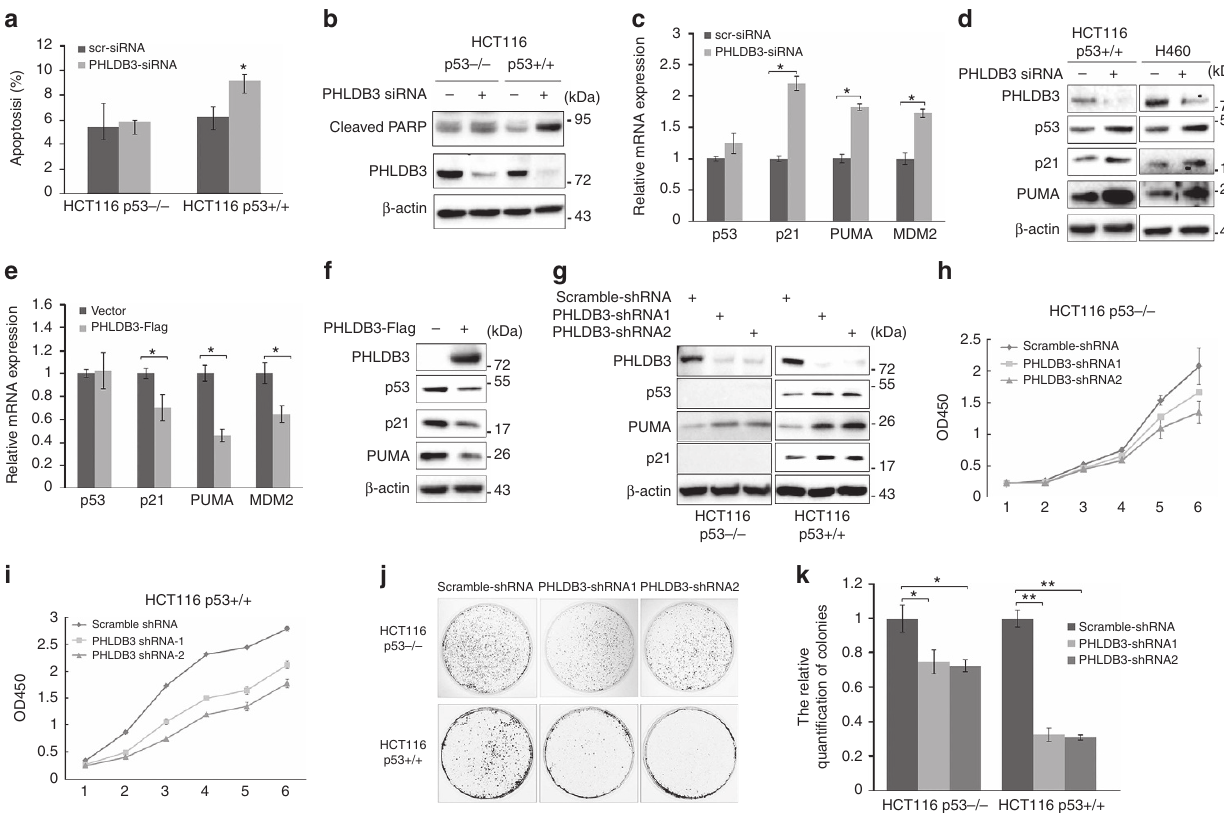
Figure 4 | PHLDB3 knockdown inhibits cell proliferation and promotes apoptosis of colon cancer cells by inducing p53 protein level. ( a , b ) The effect of PHLDB3 knockdown on apoptosis of HCT116 p53 (cid:2) / (cid:2) and HCT116 p53 þ / þ cells. HCT116 p53 (cid:2) / (cid:2) and HCT116 p53 þ / þ cells were transfected with PHLDB3 or scramble siRNA and harvested 72h post-transfection for flow cytometry analysis ( a ) or immunoblotting with indicated antibodies ( b ). Quantification of Sub-G1 population is shown in a . ( c – f ) Knockdown of PHLDB3 induces, but overexpression of PHLDB3 reduces, p53 and its target genes. HCT116 p53 þ / þ ( c , d ) and H460 ( d ) cells were transfected with PHLDB3 or scramble siRNA and harvested 72h post transfection for RT-qPCR ( c ) or immunoblotting with indicated antibodies ( d ). HCT116 p53 þ / þ cells were transfected with PHLDB3-Flag or vector plasmid and harvested 48h post transfection for RT-qPCR ( e ) or immunoblotting with indicated antibodies ( f ). ( g ) Knockdown of PHLDB3 causes p53-dependent induction of p21 and Puma. The protein levels